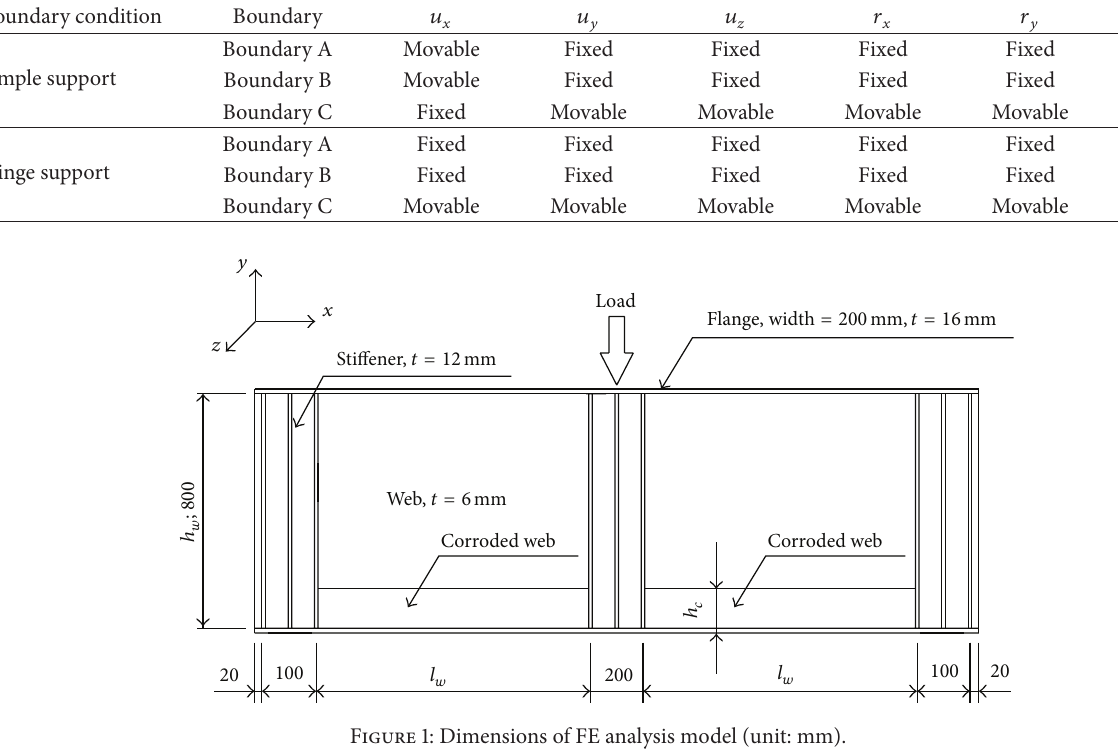
Table 1: Boundary conditions.